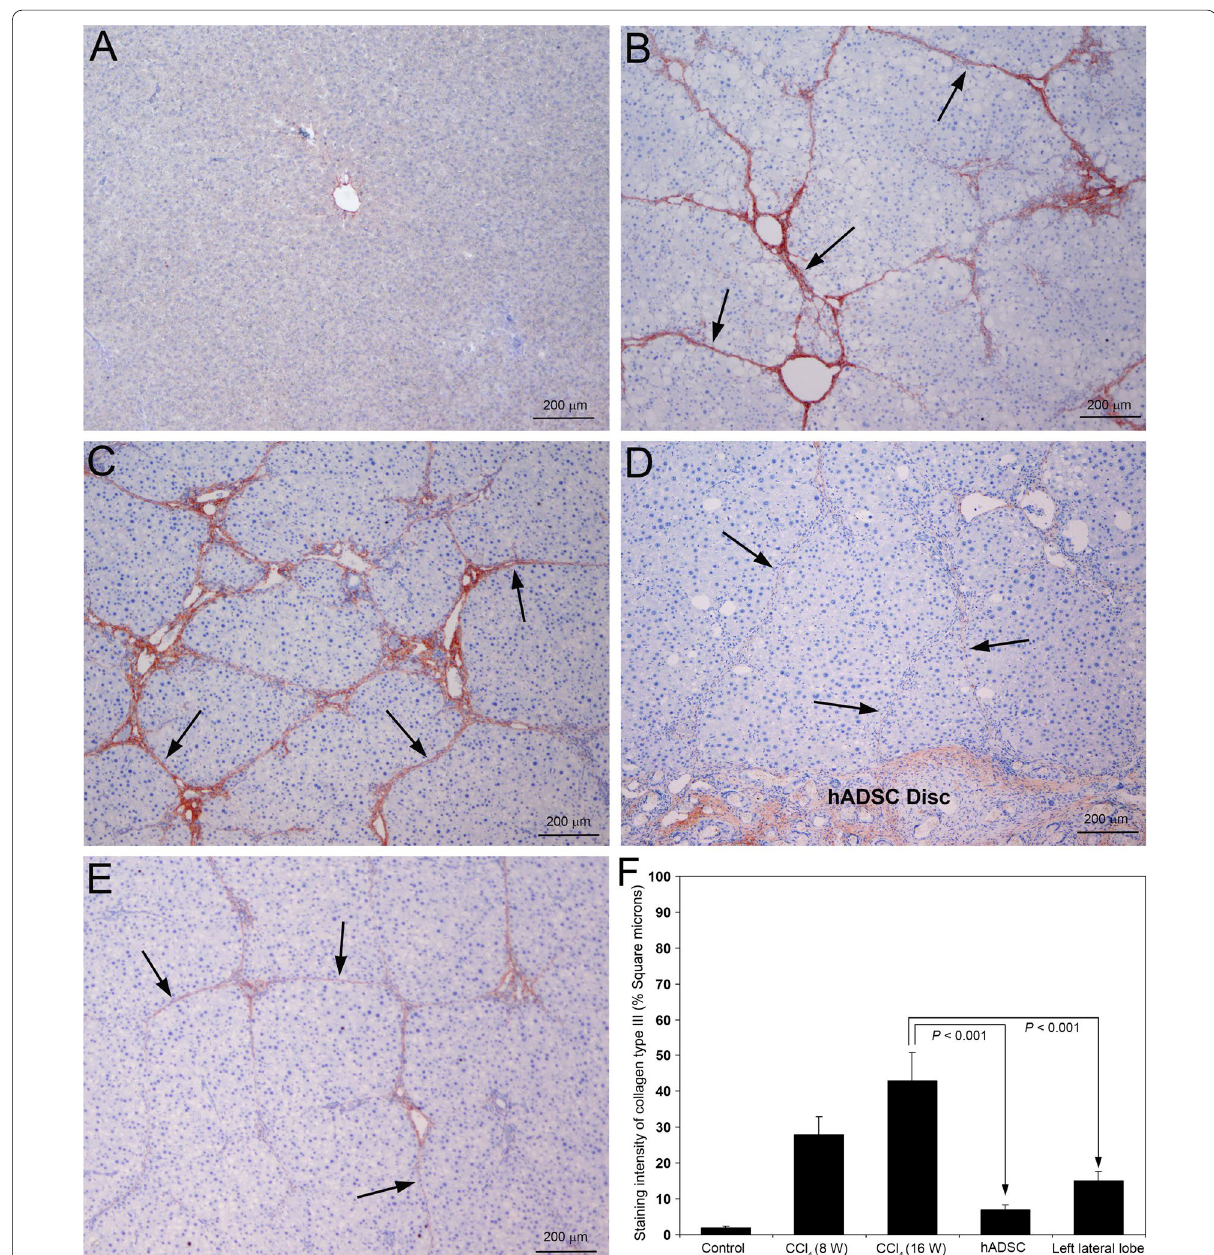
Fig. 8 Immunohistochemical staining for collagen type III in rat liver sections following serial administrations of CCl 4 and after treatment with hADSC disc. A Staining for collagen type III was completely absent in the control livers treated with olive oil for 16 weeks. B Prominent and marked staining for collagen type III was present in the fibrotic septa of all the rats treated with CCl 4 for 8 weeks (arrows). C At 16th week of CCl 4 administration, remarkable and conspicuous staining for collagen type III with thick fibers were present (arrows). D Treatment with hADSC disc for 8 weeks depicted marked reduction in staining for collagen type III with feeble and incomplete collagen fibers (arrows). E Significant decrease of staining for collagen type III in the left lateral lobe, where the right lateral lobe is implanted with hADSC disc. Collagen fibers were thin with incomplete fibrous septa and partial bridging (arrows). Original magnification, 40. F The intensity of collagen type III staining was quantified using × Image-Pro Discovery software. The data are mean S.D. of 10 randomly selected microscopic fields from five rats per ±